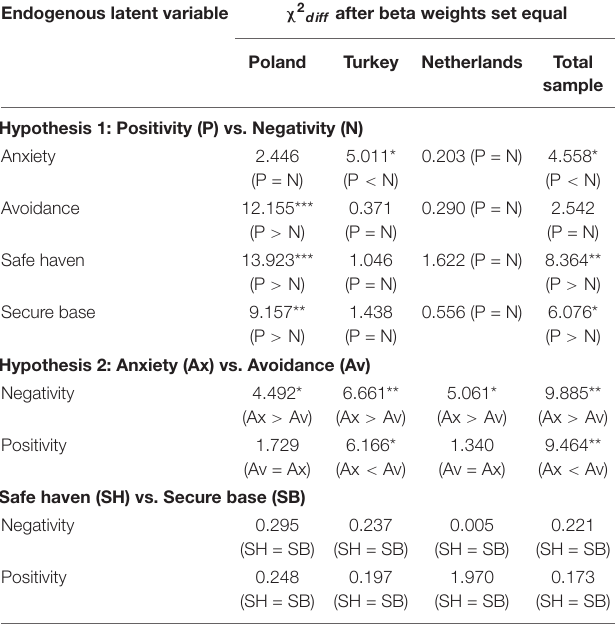
TABLE 2 | Chi square differences ( χ 2 diff ) of: (1) a model with free estimated paths versus (2) a model with two compared paths set equal (positivity-attachment versus negativity-attachment; anxiety-negativity/positivity versus avoidance-negativity/positivity; and safe haven-negativity/positivity versus secure base-negativity/positivity) in cultural groups and in the total